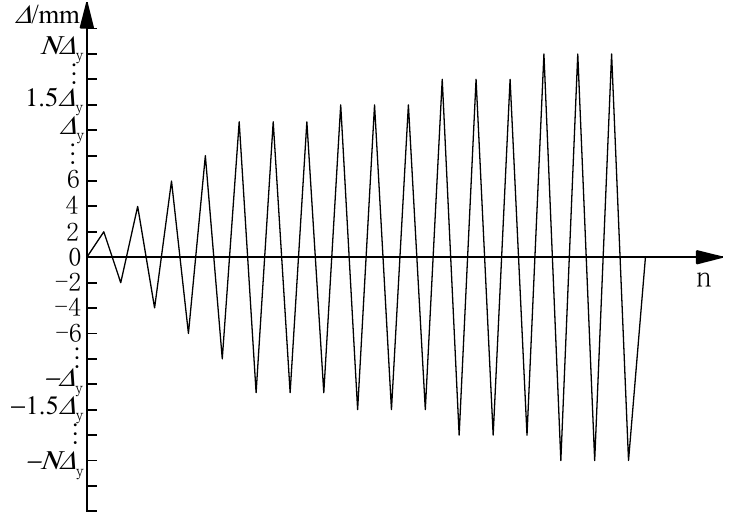
Figure 3. Loading history.